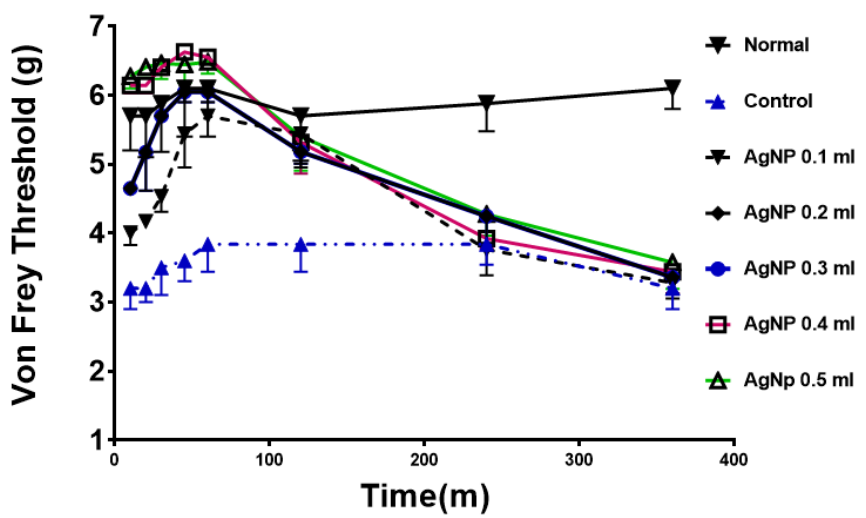
Figure 3. Anti-hyperalgesic effects of AgNPs treatment in rats. Normal; animals before constrictive surgery, control in blue; animals after surgery and before AgNPs treatment. All treated animals showed a significant difference compared to control group up to 2 h time point. ( p < 0.05) “ n ” = 8.